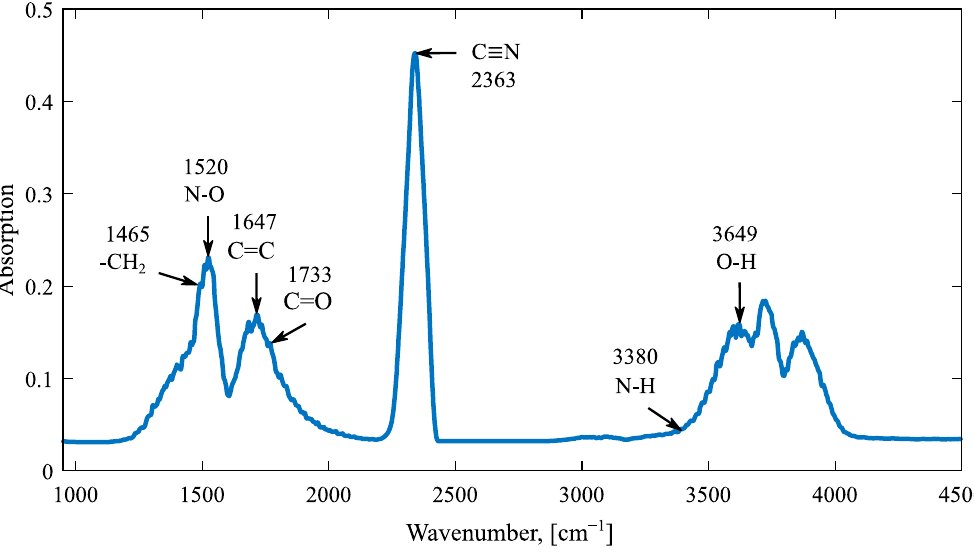
Figure 6. FTIR spectra of HDPU foam combusted at 50 kW/m 2 .